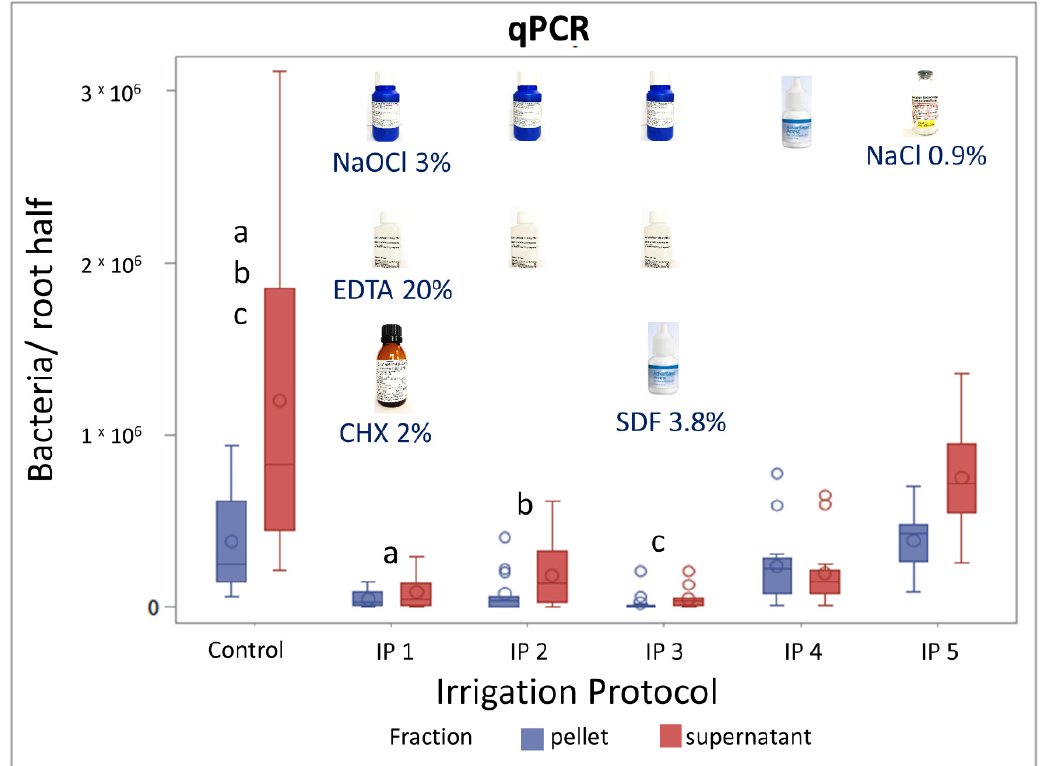
Figure 2. Quantification of bacterial DNA after application of different irrigation protocols on infected root canals with E. facalis using qPCR. Effect of different irrigation protocols (IP 1–5), ( n = 10) compared with a control group ( n = 8) on the number of bacteria in the infected root dentin slices. Statistically significant (a, b, c) reductions compared to the control group were obtained with IP 1, IP 2, and IP 3 in the pellet and supernatant fractions ( p ≤ 0.05; mixed models).